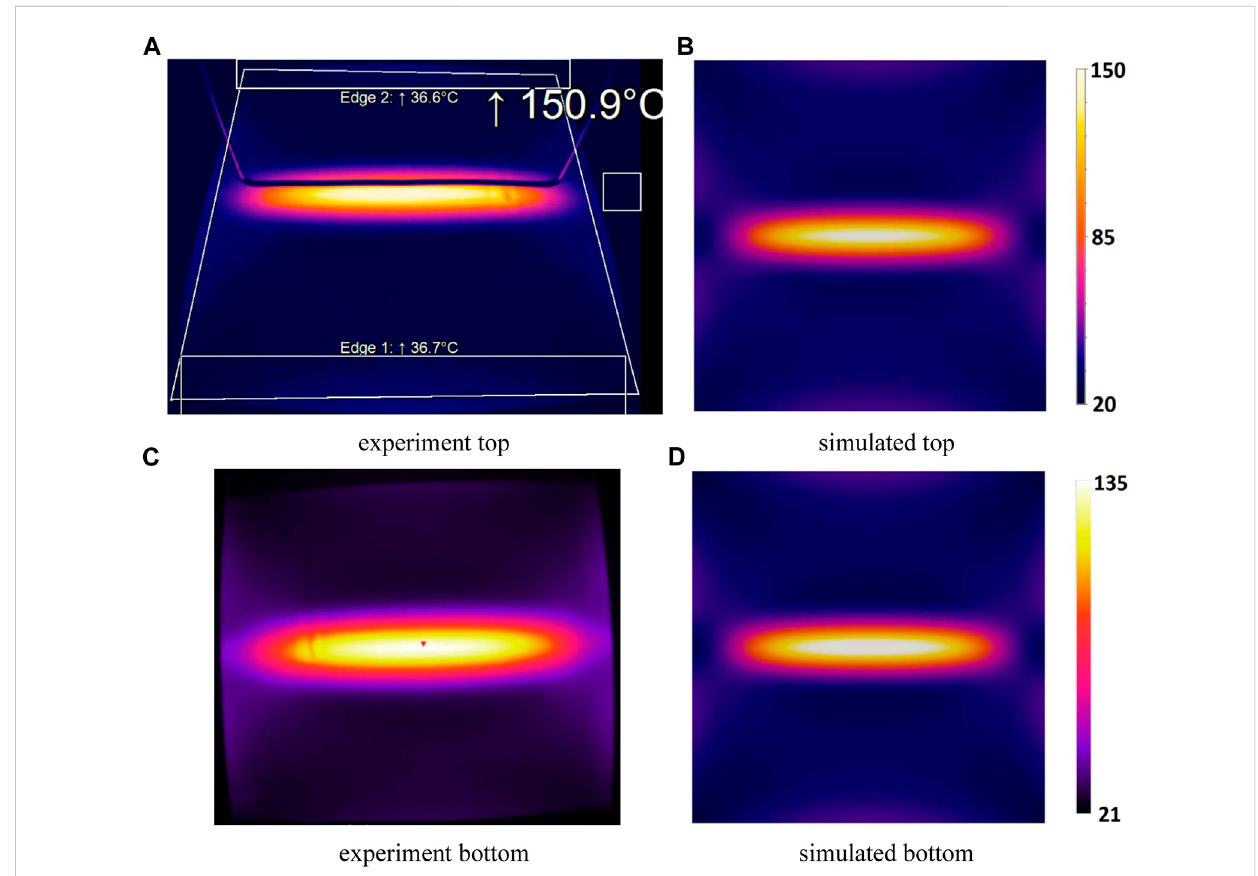
FIGURE 17 Temperature contour plot for the cross ply [0,90] 9s plate (A1). (A – C) correspond to measurements whereas (B – D) correspond to simulated values.